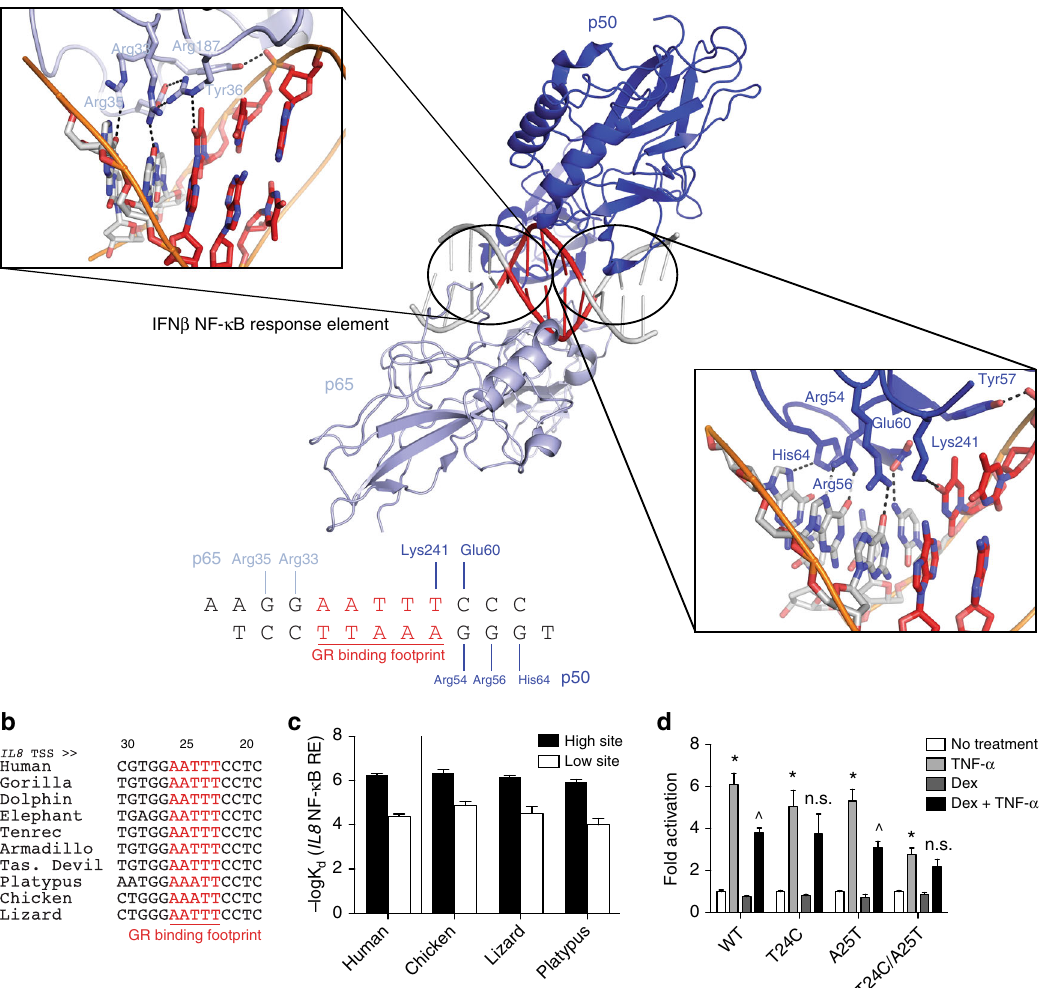
Fig. 6 The GR DBD binds to a cryptic sequence in the spacer of NF- κ B response elements. a Crystal structure of the p50/p65 NF- κ B heterodimer bound to its cognate response element in the IFN β promoter 71 . The GR-binding footprint (AATTY sequence) at this response element is shown in red. At this element (and many of its other response elements), NF- κ B largely makes sequence-speci fi c contacts with the regions fl anking the AATTY motif (see insets). However, despite the lack of sequence-speci fi c contacts by NF- κ B in this spacer region, the AATTY motif is highly conserved; the conservation of the AATTY motif within the IL8 NF- κ B response element is shown in b . c In addition, the GR DBD can bind to the IL8 NF- κ B response element from divergent species with nearly-identical af fi nities. d Finally, mutation of central, conserved bases within the AATTY motif of the IL8 promoter affects the ability of dexamethasone to repress transcription from this response element in HeLa cells. * p < 0.001 of TNF- α vs. no treatment; ^ p < 0.001 of TNF- α vs. TNF- α + Dex; NS, no signi fi cance between TNF- α vs. TNF- α + Dex. Statistics are two-way ANOVA with Tukey ’ s post-hoc